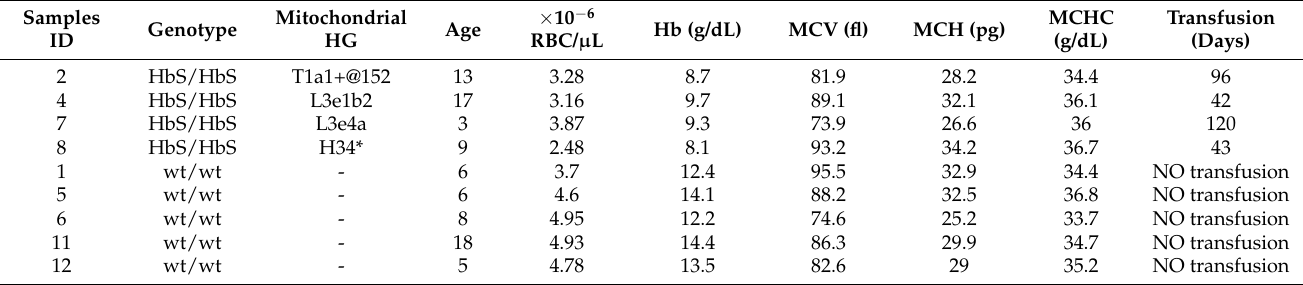
Table 2. The table shows genetic and clinical profiles acquired for each sample: the age, the number of red blood cells for microliter (RBC/uL), the level of hemoglobin present (Hb), the value of MCV (Mean Corpuscular Volume), MCH (Mean Cell Hemoglobin), MCHC (Mean Corpuscular Hemoglobin Concentration), mitochondrial haplogroups (HG), and the number of days since the last transfusion for the HbS